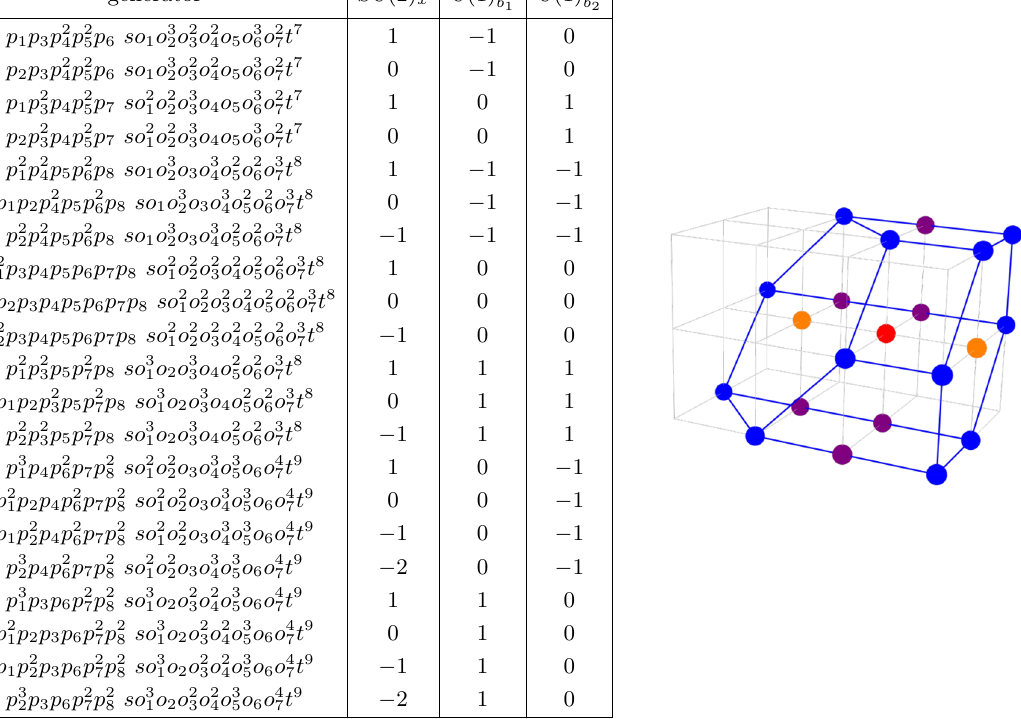
Table 72 . The generators and lattice of generators of the mesonic moduli space of Model 18 in terms of brick matchings with the corresponding flavor